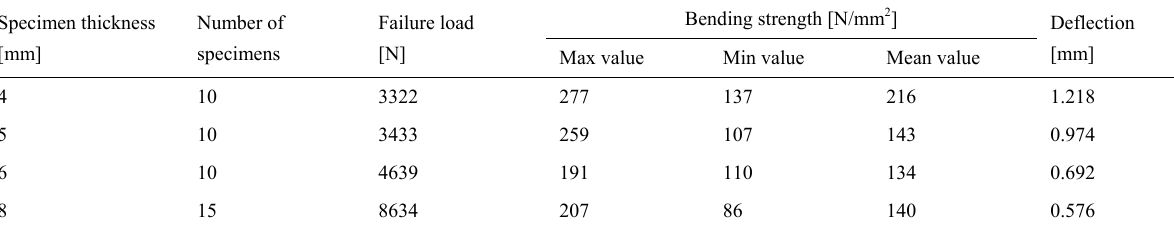
Fig. 6 Coaxial double rings test results: a) cracking pattern induced due to a concentration of both tangential and radial stresses close to the loading ring; b) cracking pattern induced due to a concentration of both tangential and radial stresses in locations between the two rings. The strength testing data, as well as the number of valid test results (all strength data shown is only for test plates that fractured in a valid fashion), are summarized in Table 1 for all four glass thicknesses examined. The data are summarized in mean values of the bending strength calculated using eq.1 and extreme values of the strength range. The last column of the table 1 shows the recorded deflection. Table 1: Summary of experimental